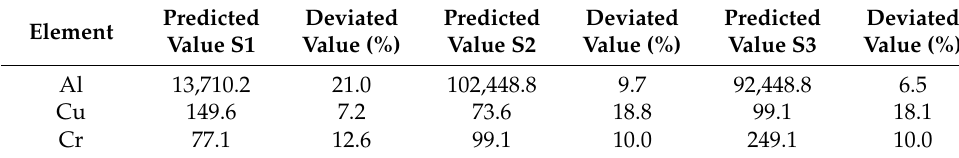
Table 5. Predicted and deviated values of concentrations in unknown samples. Element